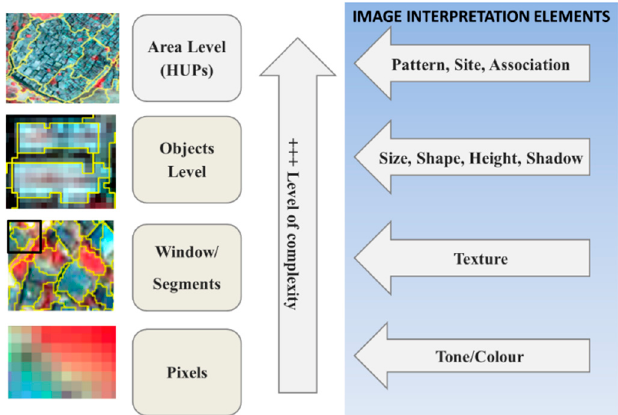
Figure 6. Complexity of image interpretation elements (adapted from [41,176,177]).